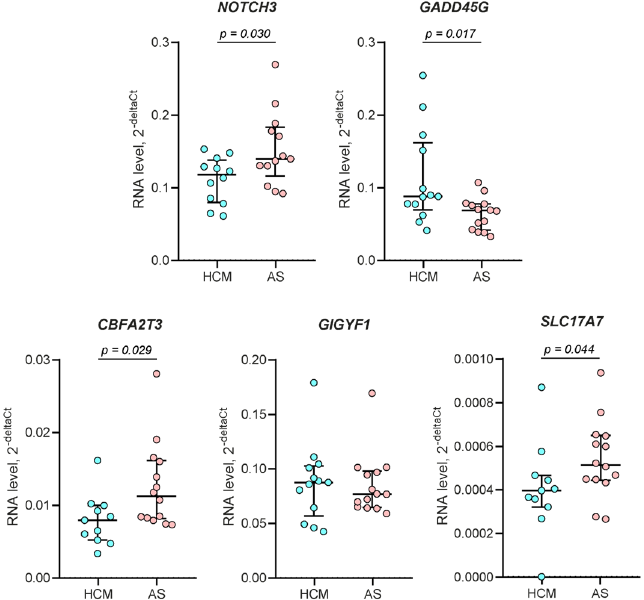
Figure 4. Expression levels of NOTCH3 , GADD45G , GIGYF1 , SLC17A7 , and CBFA2T3 in 13 HCM patients and 14 AS patients, as determined via RT ‐ qPCR. RNA levels were calculated relative to GAPDH . The data are presented using a scatter plot (median with interquartile ranges). The differ ‐ ences in RNA levels between HCM patients and AS patients were considered to be significant if the p ‐ value in the Mann–Whitney U test was less than 0.05.